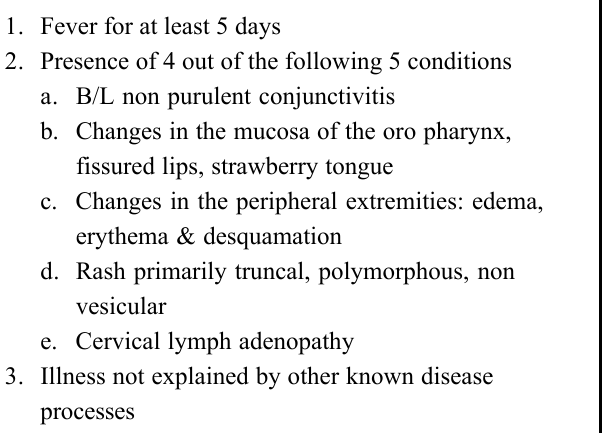
Table I: Clinical diagnostic criteria for Kawasaki disease